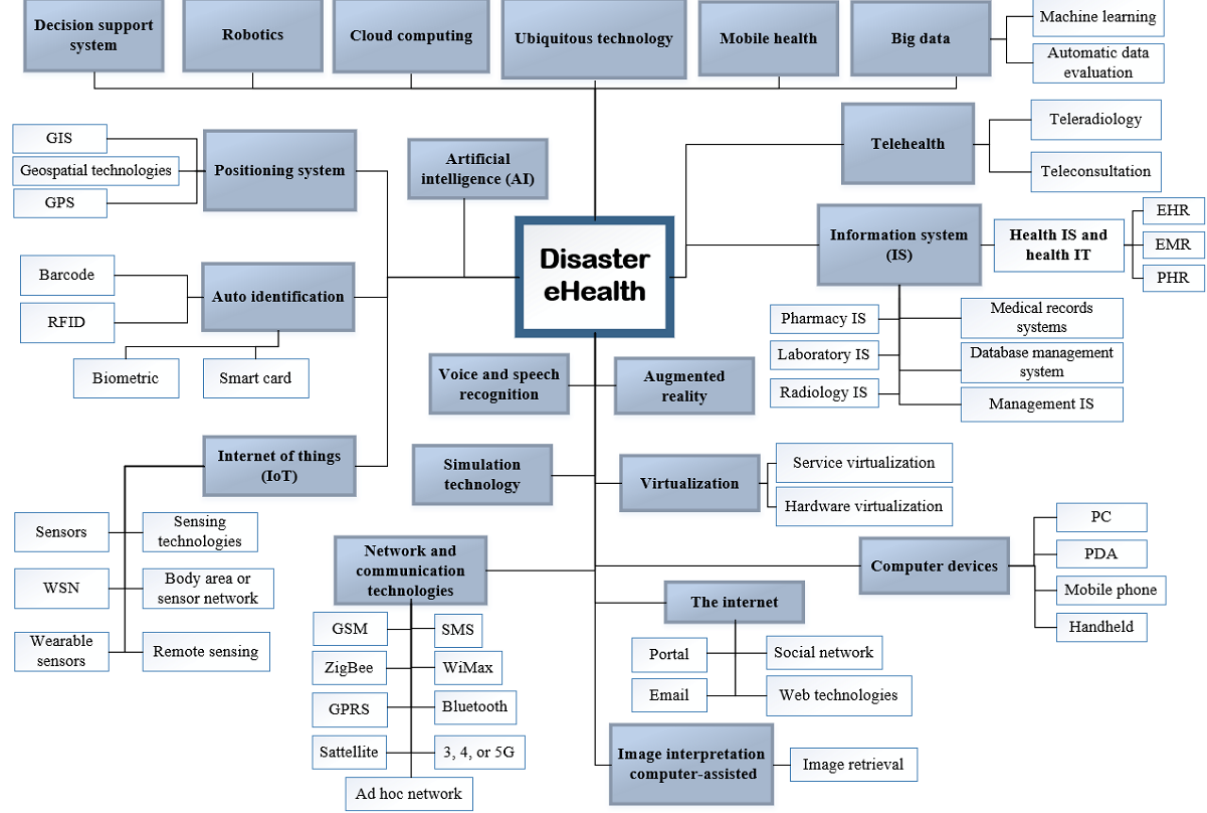
Figure 6. Technologies within disaster eHealth scope. EHR: electronic health record; EMR: electronic medical record; GIS: geographic information system; GPRS: General Packet Radio Service; GSM: Global System for Mobile Communications; IS: information system; IT: information